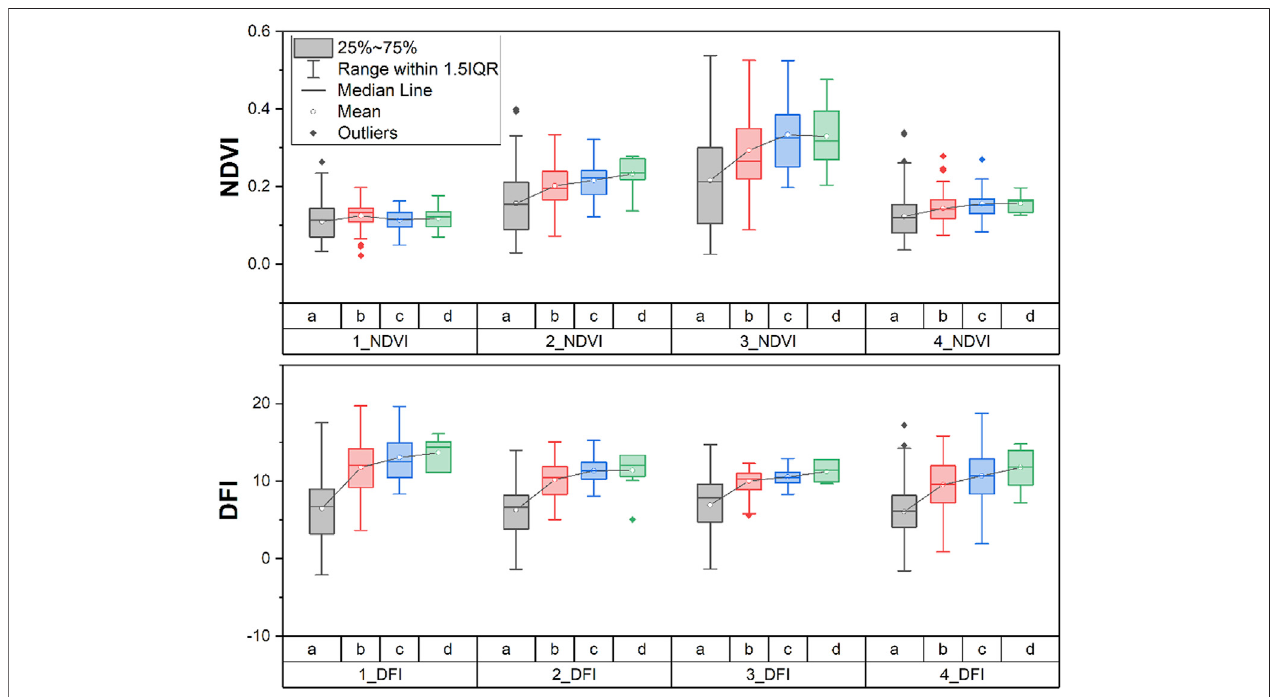
FIGURE8| Dynamicdistributionofvegetationindexatdifferentsoilorganicmatter(SOM)contentgrades(a:SOMcontentwas0 ‒ 1%;b:SOMcontentwas1 ‒ 2%; c: SOM content was2 ‒ 3%; d:SOMcontentwas 3 ‒ 4%;1_NDVI: Normalized difference vegetation index (NDVI) in the fi rst quarter; 2_NDVI: NDVI inthe second quarter; 3_NDVI: NDVIin thethird quarter; 4_NDVI: NDVIinthe fourth quarter; 1_DFI: DFI inthe fi rst quarter;2_ DFI: Dead fuelindex (DFI) inthe second quarter; 3_ DFI:DFI in the third quarter; 4_ DFI: DFI in the fourth